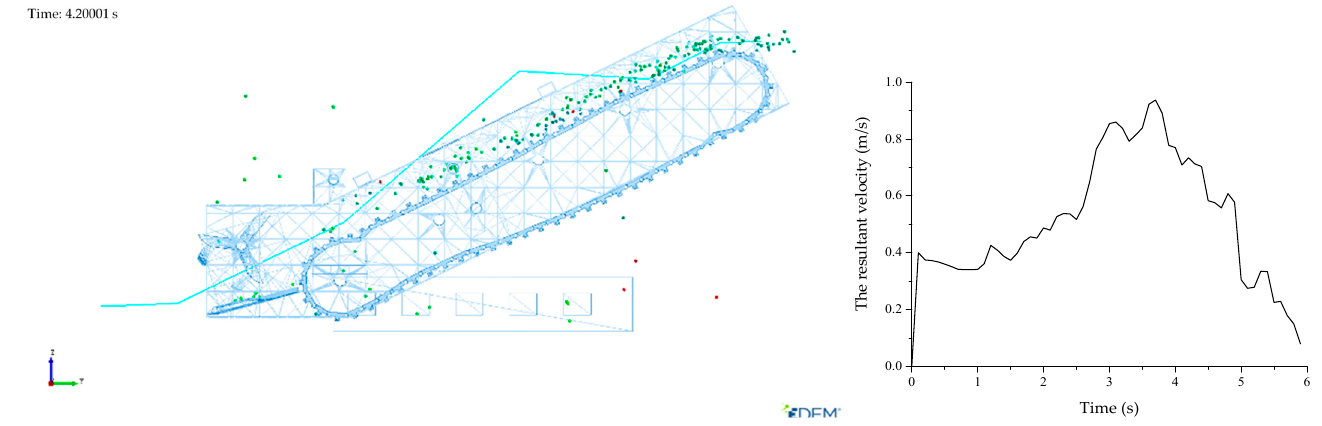
Figure 16. Simulation of the motion of tiger-nut tubers and the resultant velocity.